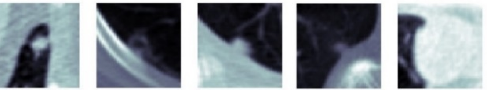
Figure 40. MFMPF model based on fusion of all—missed nodules (FN).